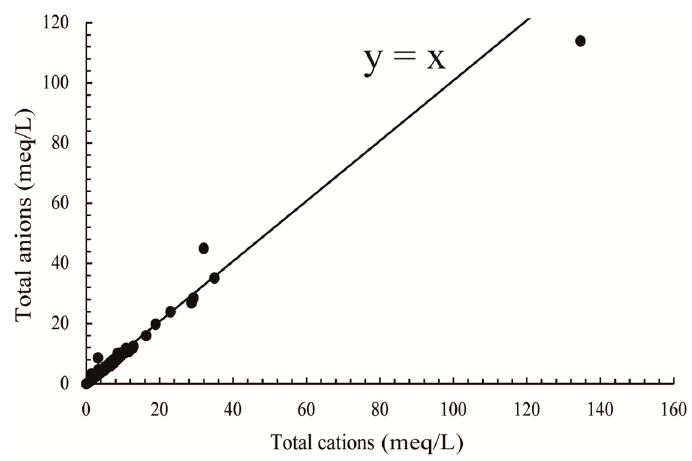
Figure 2. Total cations versus total anions in water samples from Tibet.